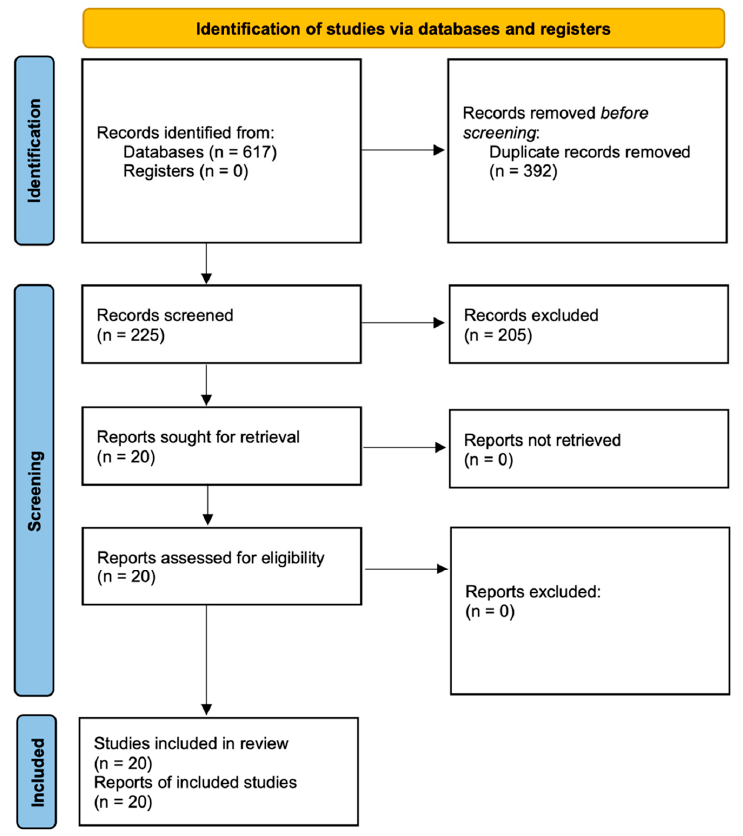
Figure 1. Systematic flow chart representing the study selection process, based on the PRISMA 2020 flow diagram [18].